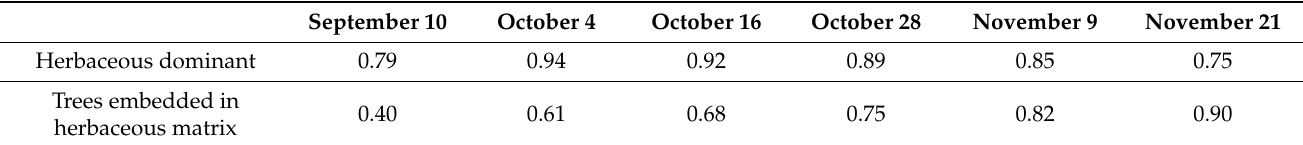
Table 3. Overall accuracy of SWDI detection for two major land cover